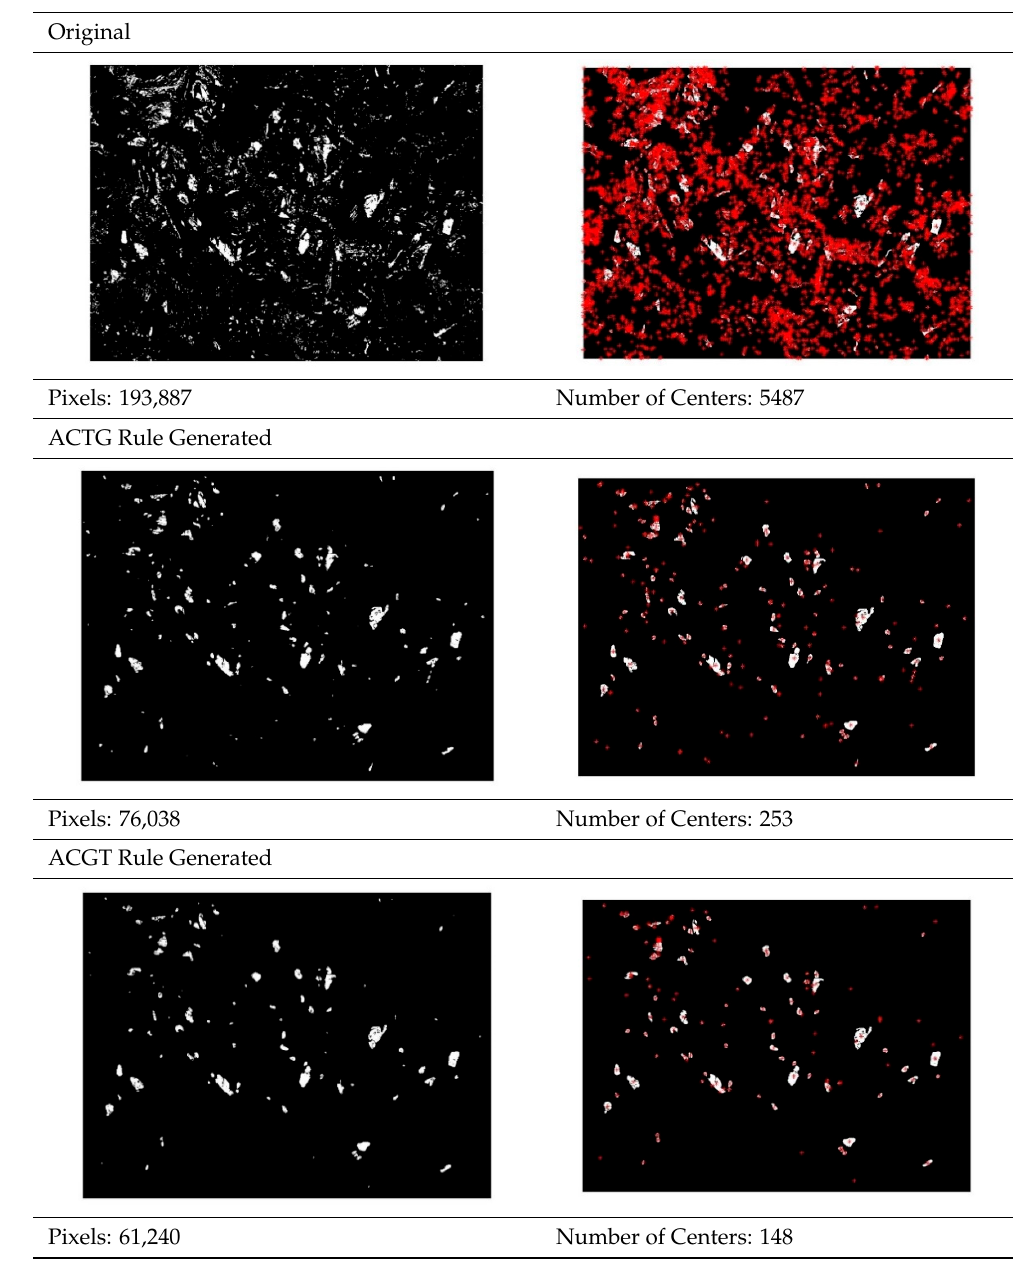
Table A7 . Images and associated pixels and number of centers corresponding to VR = − 0.5.